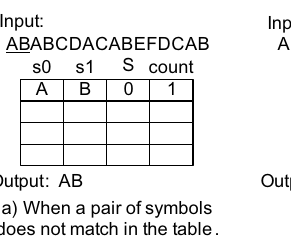
Figure 3. Compression example of